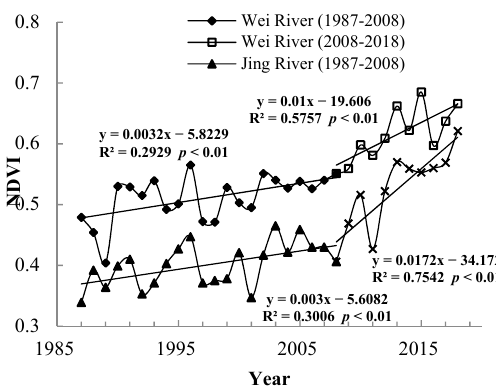
Figure 4. Trend of NDVI in Wei and Jing River Basin during 1987–2018.